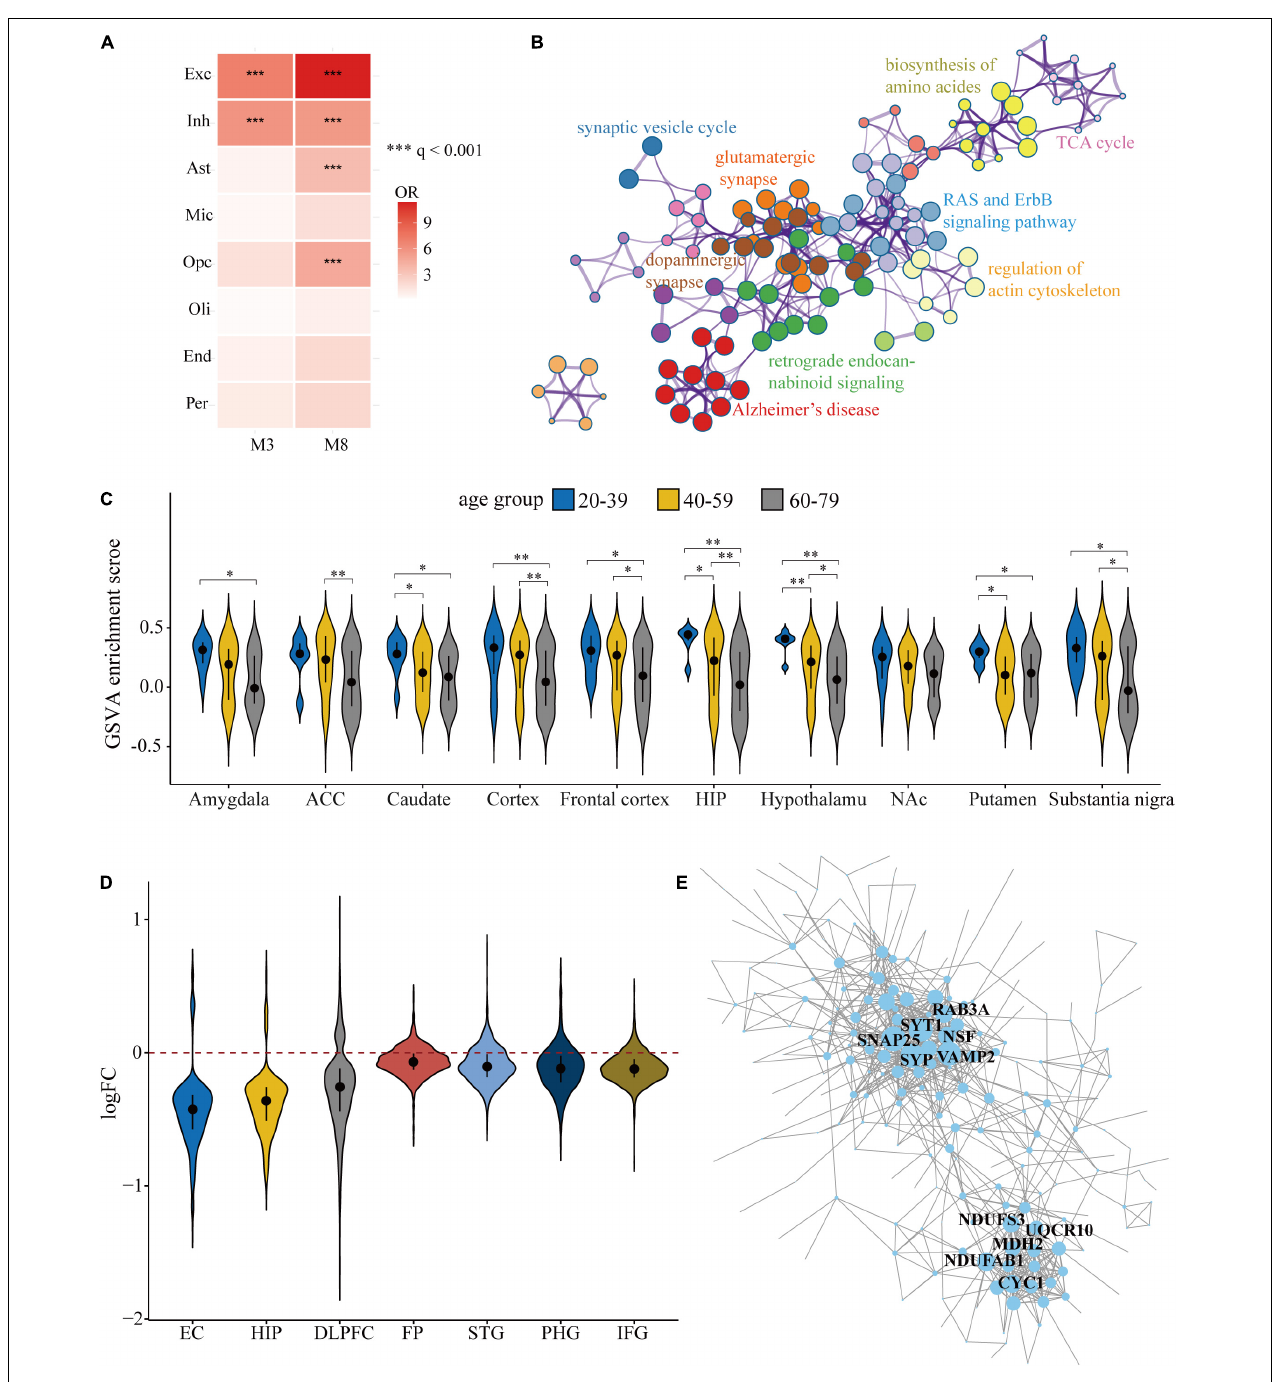
FIGURE 3 | Functional enrichment and expression changes of M3 and M8 in normal aging and AD across multiple cerebral regions. (A) Brain cell-type enrichment for M3 and M8. The heatmap shows the one-tailed Fisher’s exact test (FET) results with BH correction for each brain cell type. Exc, excitatory neurons; Inh, inhibitory neurons; Ast, astrocytes; Mic, microglia; OPC, oligodendrocyte progenitor cell; Oli, oligodendrocytes; End, endothelial cells; Per, pericytes. (B) Kyoto encyclopedia of genes and genomes (KEGG) pathway enrichment analysis for M3 and M8. The enrichment network shows the intra-cluster and inter-cluster similarities of enriched KEGG terms. Color code represents the cluster annotations. (C) Comparison of sample-wise gene set enrichment scores of M3 and M8 in three different age groups of different cerebral regions. Kruskal-Wallis test with Benjamini-Hochberg correction was used to determine statistical significance. The black circle and bar represent median and quartiles (25th and 75th percentile), respectively. ∗ q < 0.05, ∗∗ q < 0.01, ∗∗∗ q < 0.001. ACC, Anterior cingulate cortex; HIP, hippocampus; NAc, nucleus accumbens. (D) Violin plots of logFC values for genes of M3 and M8 between AD cases and controls in 7 cerebral regions. EC, entorhinal cortex; HIP, hippocampus; DLPFC, dorsolateral prefrontal cortex; PCG, postcentral gyrus; FP, frontal pole; STG, superior temporal gyrus; PHG, parahippocampal gyrus; IFG, inferior frontal gyrus. (E) PPI network of 345 DEGs with absolute logFC > 0.2 and q < 0.05 in at least 4 brain regions. The network was created by representing each gene as a node and connecting pairs of nodes with confidence > 0.5. Node size is proportional to the degree. Hub genes with the highest degrees are labeled in black.